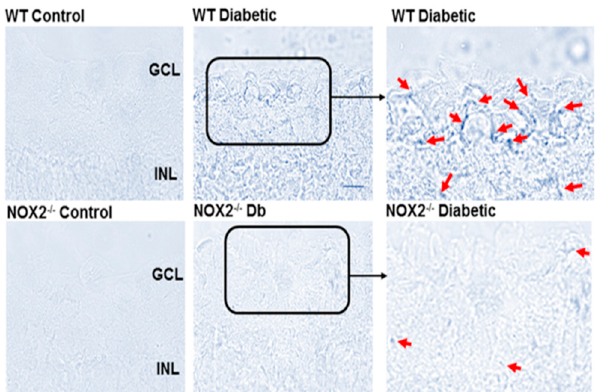
Figure 3. NOX2 deletion limits diabetes-induced increases in SA- β -gal activity. Representative images showing effects of diabetes on SA- β -gal activity in the inner retina. Retinas of WT diabetic mice showed numerous SA- β -gal positive cells (red arrows) in the inner retina. The SA- β -gal signal is largely absent in retinas from the NOX2 − / − diabetic mice. Scale bar = 50 µm.